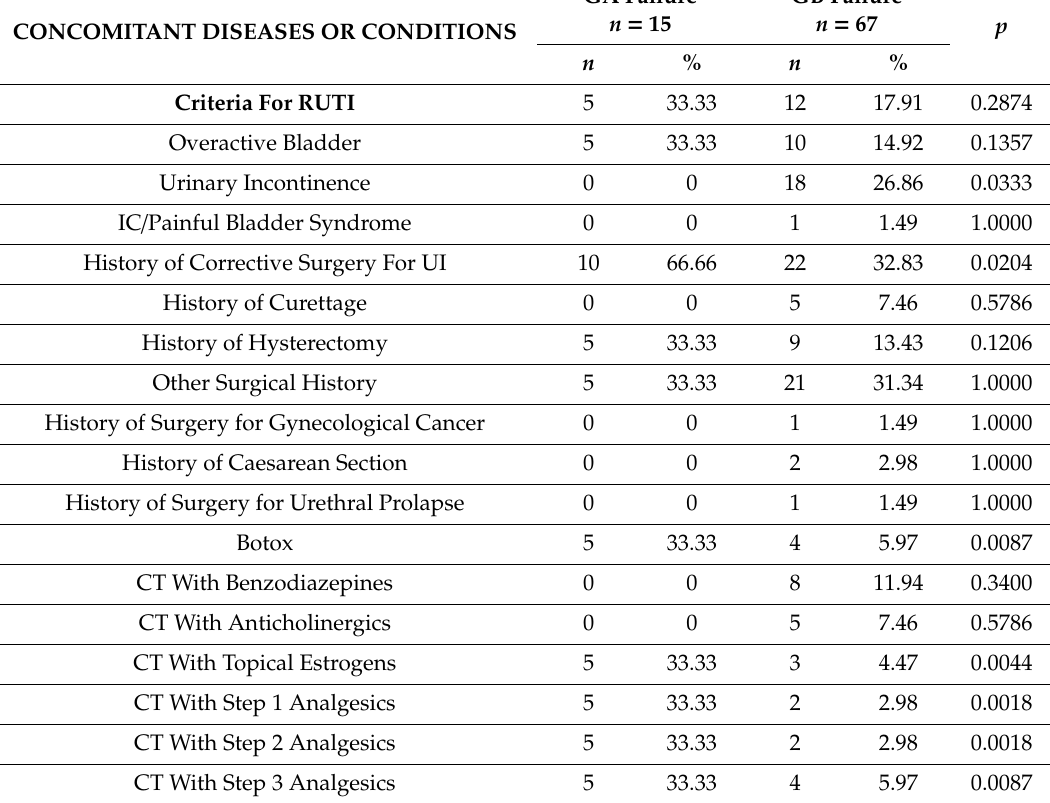
Table 4. Distribution of diseases and concomitant health conditions in GA and GB in which there was no significant improvement in HRQoL SF-36